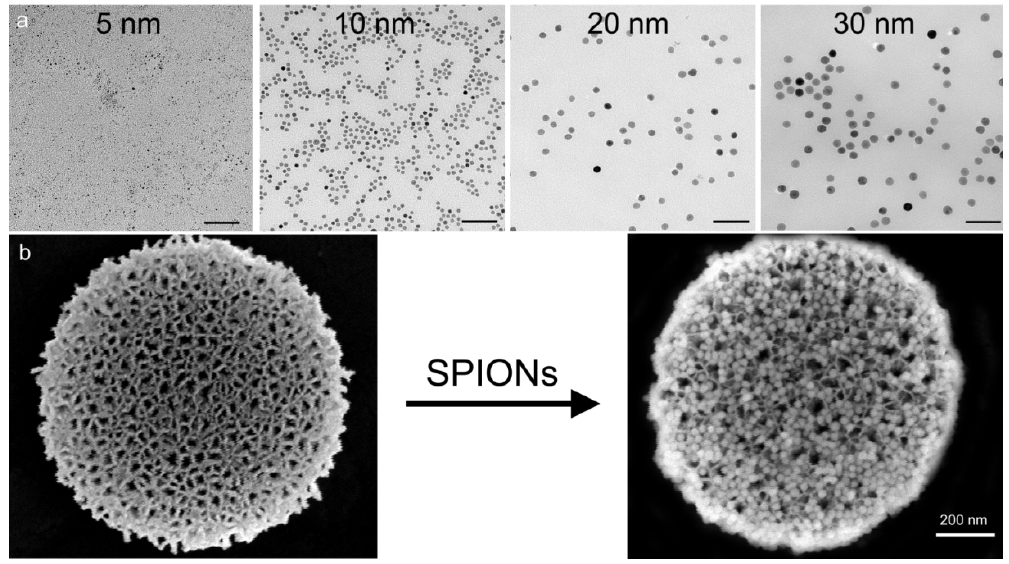
Figure 1. Electron micrographs of single and hybrid particles. ( a ) TEM images of superparamagnetic iron oxide nanoparticles (SPIONs) with core sizes of 5, 10, 20, and 30 nm on 400 mesh formvar carbon grids, imaged at 200,000× direct magnification (bars = 100 nm); ( b ) SEM images of discoidal porous silicon (pSi) microparticles, unloaded ( left ) or loaded with 30 nm SPIONs ( right , with image periphery pseudo-colored